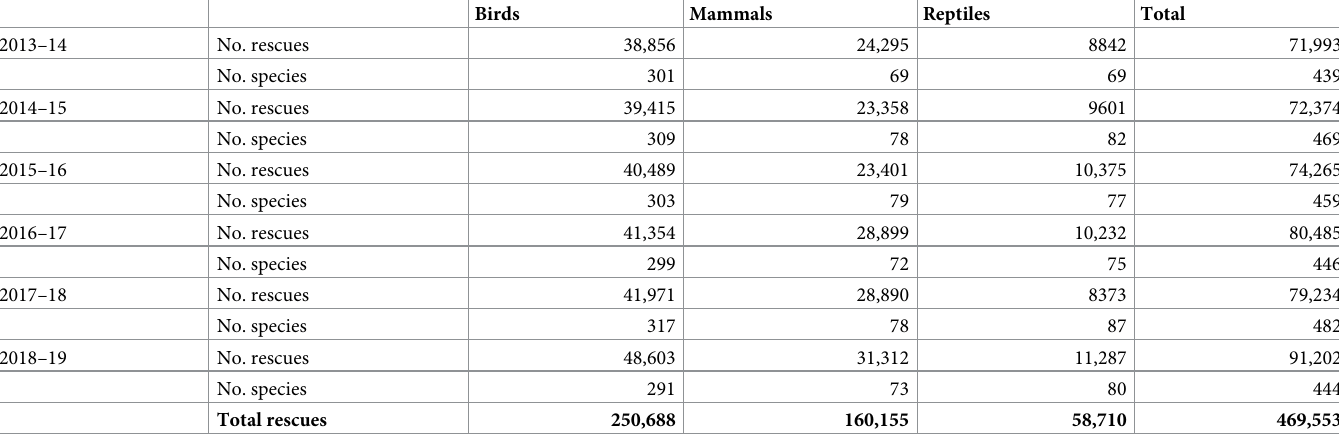
Table 3. Number of species reported for each animal group each year during the study